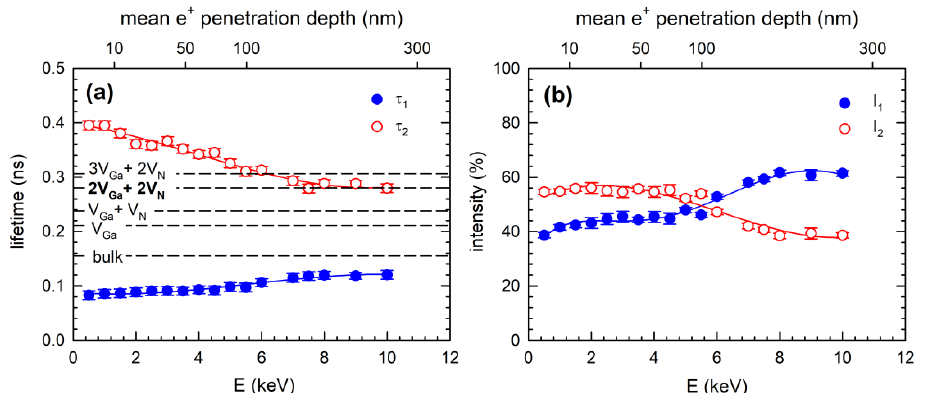
Figure 6. Results of breaking down positron lifetime spectra for the TMH3 sample ( a ) lifetimes τ 1 and τ 2 of the components resolved in spectra and ( b ) intensities I 1 and I 2 of the components. Dashed lines indicate calculated bulk positron lifetime and the lifetimes of positrons trapped in various defects. The mean positron penetration depth is shown in the upper x -axis. The solid lines serve to guide the eye.